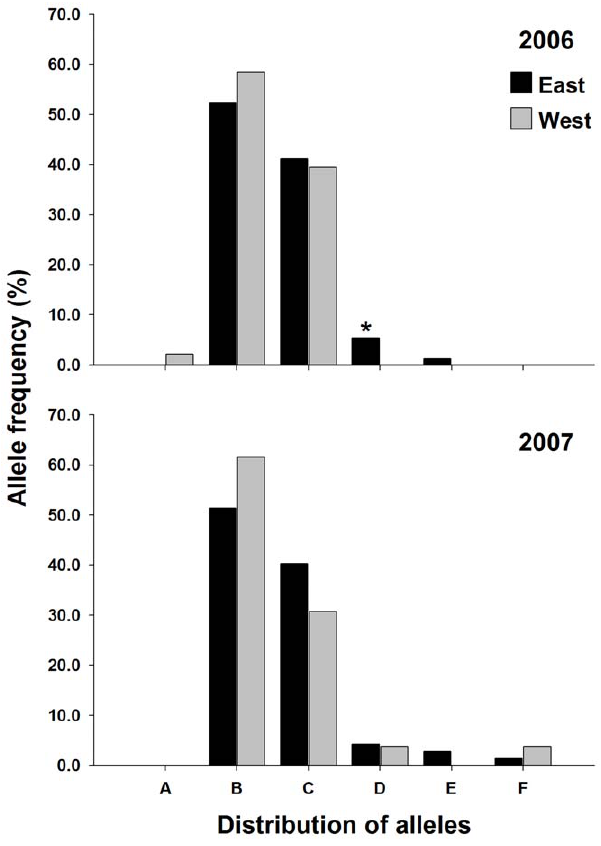
Figure 5. Distribution of alleles for microsatellite locus CT2 in in 2006 and 2007. *Denotes private alleles with a frequency of .